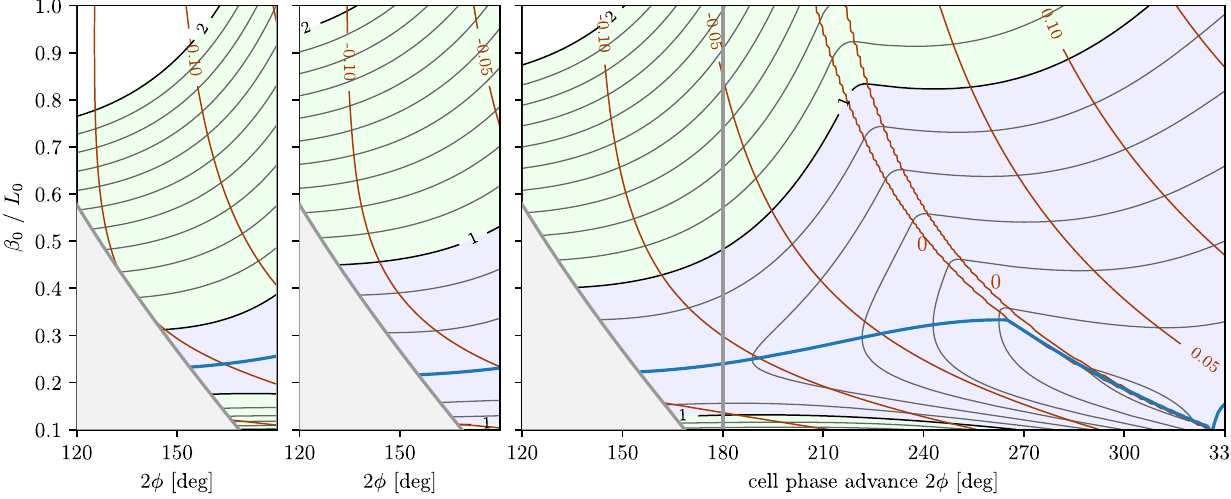
FIG. 15. Emittance ratio F for LGB/RB cells with IDM magnet at R ¼ 2 (see legend in Fig. 13) with different values of β 1 at the reverse-bend center. From left to right: β 1 ¼ 20 L 0 , β 1 ¼ 40 L 0 , β 1 ¼ 30 L 0